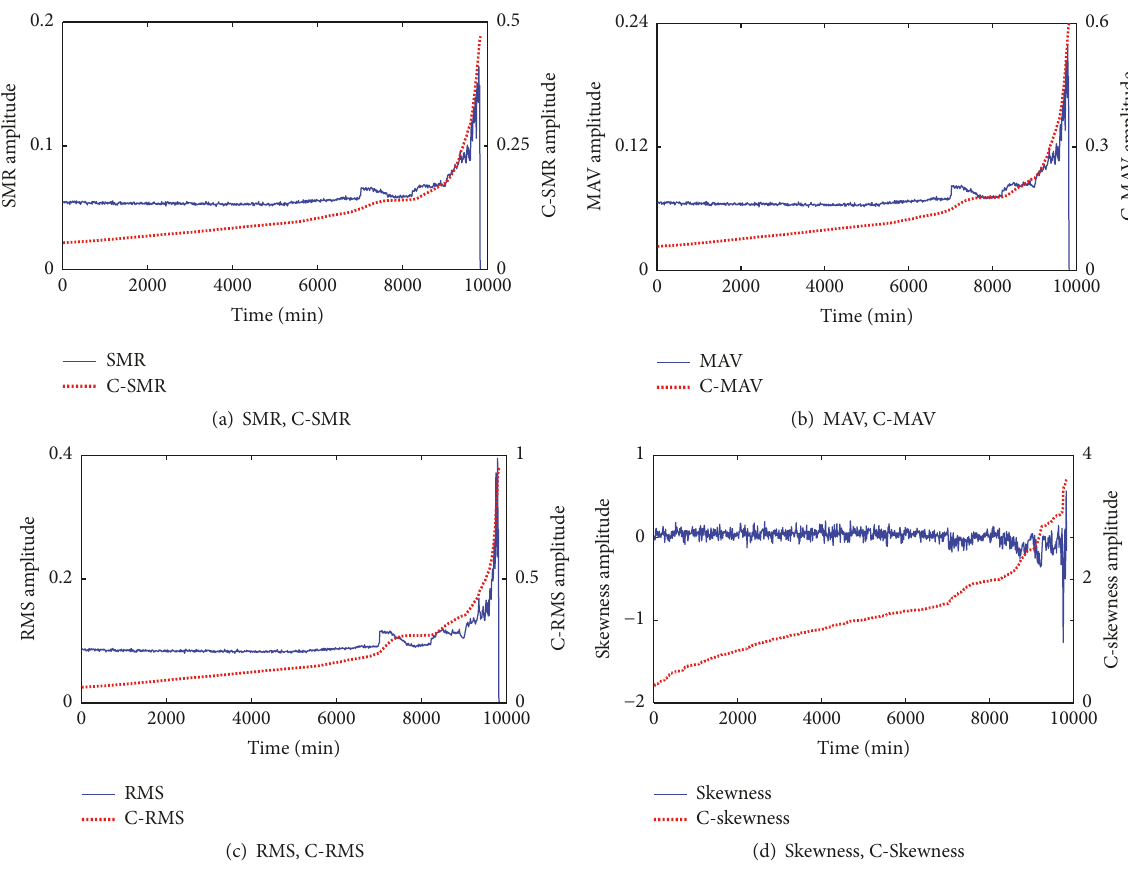
Figure 9: Fifth to eighth preferred features and corresponding cumulative features.